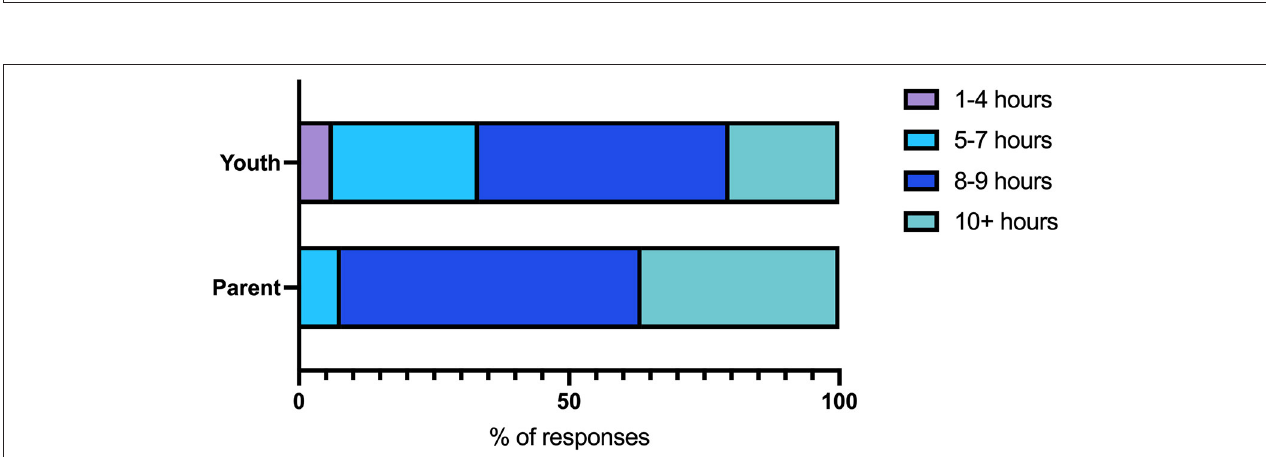
FIGURE 5 | Number of hours of sleep within a 24-h period as reported by children and youth or parents.